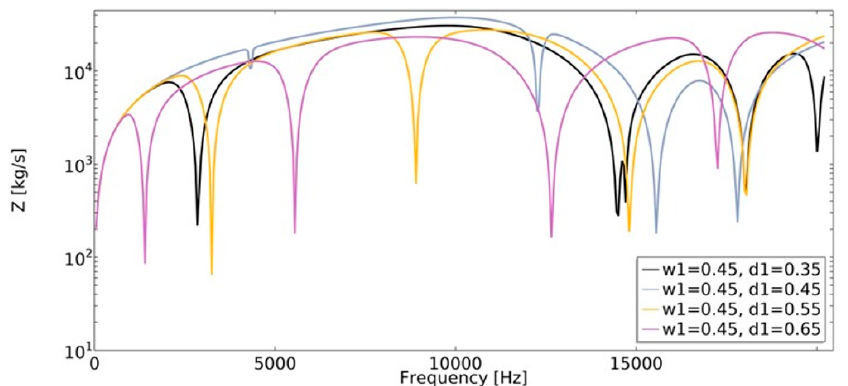
Figure 20. The influence of geometric features on the value of mechanical impedance in the fre- quency range of 1–20,200 Hz for w 1 = 0.45.